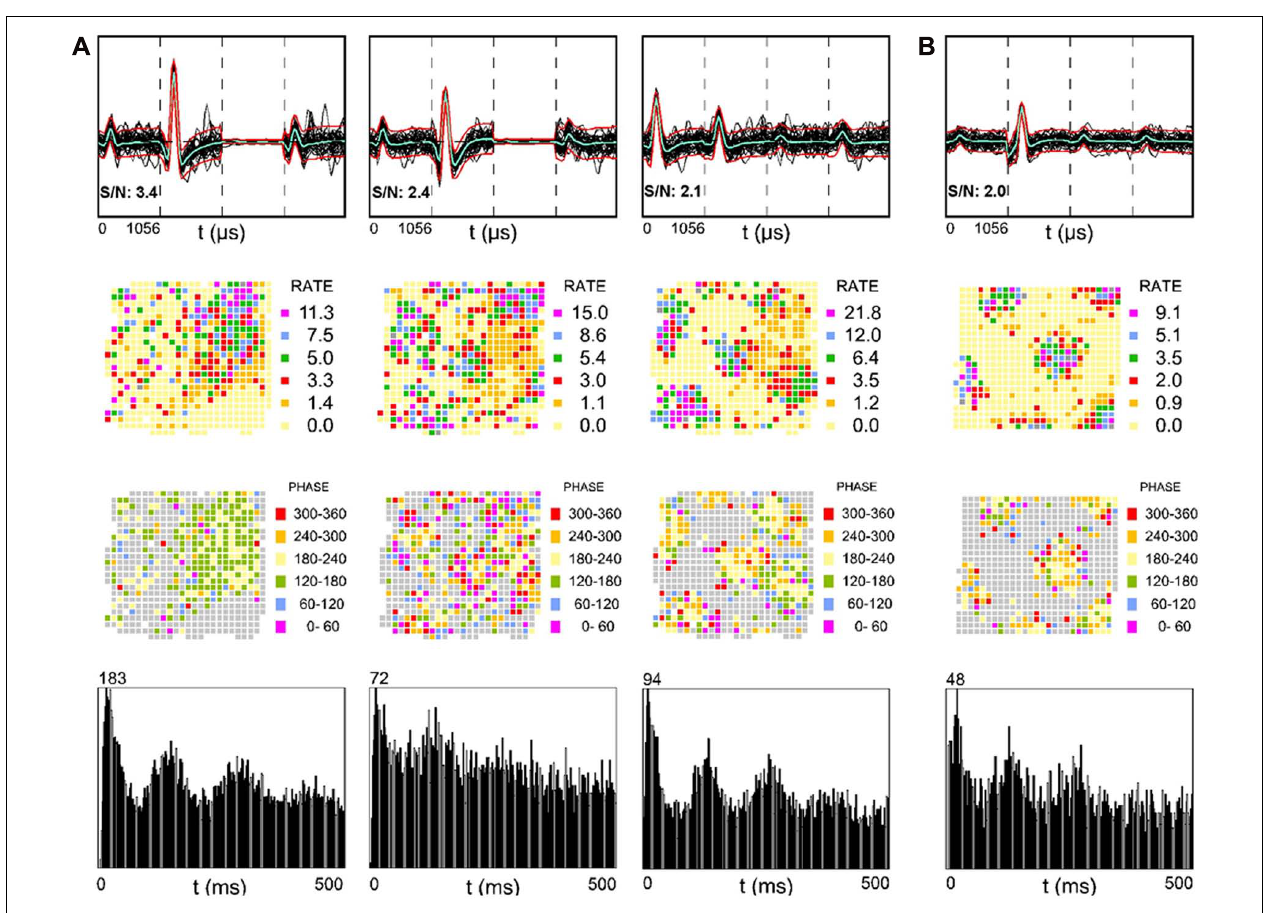
FIGURE 2 | Examples of SDWs recorded from the alveus in the absence of somatic activity compared across each wire of a tetrode (top row) and its corresponding firing rate map (second row), phase map (third row), and autocorrelogram (fourth row). The three examples on the left were simultaneously recorded from one rat (A) while the example on the far right was recorded from a different rat (B) . The overlay of 60 spikes as well as the average waveform for each SDW is displayed for each wire (top row). The third channel in each of the two examples on the far left is flat, denoting a malfunctioning electrode channel. recording channel. The discharges of several of the SDWs shown are indicative of